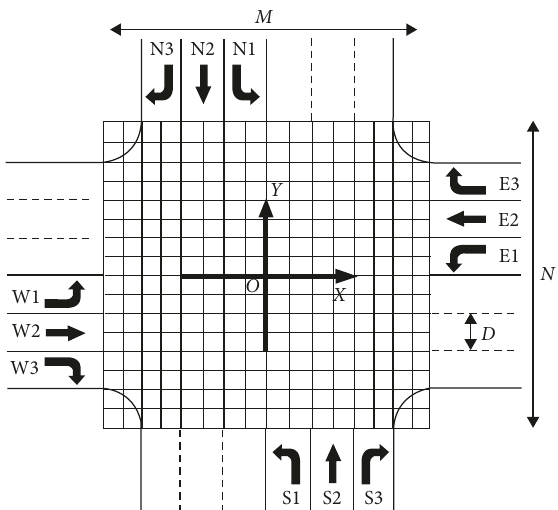
Figure 2: Coordinate system and cell division of conflict area in a signalized